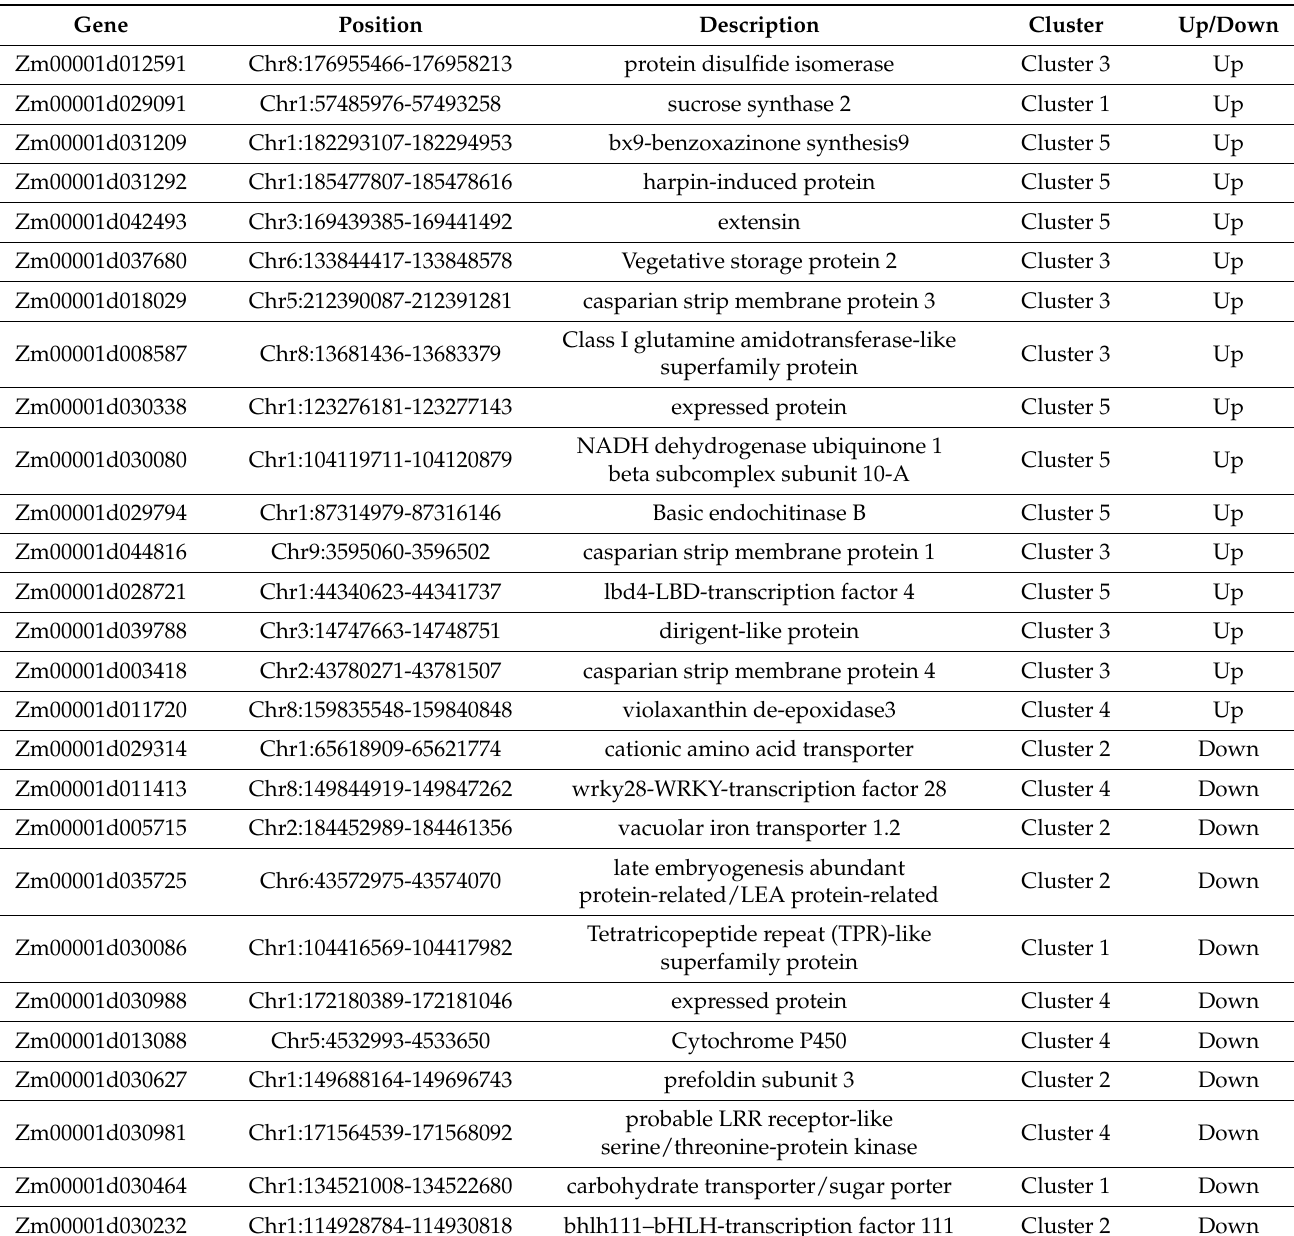
Table 2. Common DEGs for tolerant line (L220, NIL3, and NIL25) specially expressed cold germina- tion